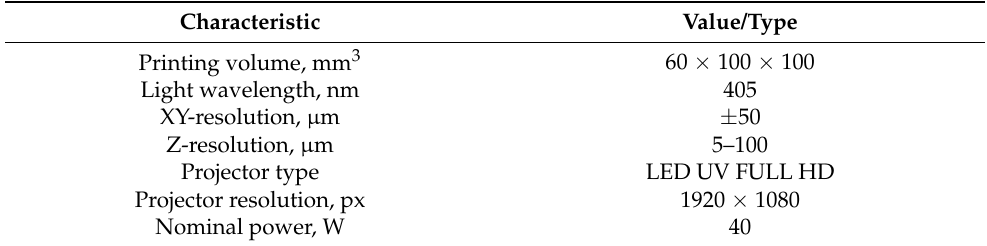
Table 3. Main mechanical properties of the Share-HT photoactive resin used for the realization of the 3D models of the cerebral aneurysms. The values reported are those declared by the producer. Property ASTM Value Tensile strength at break, MPa D-638